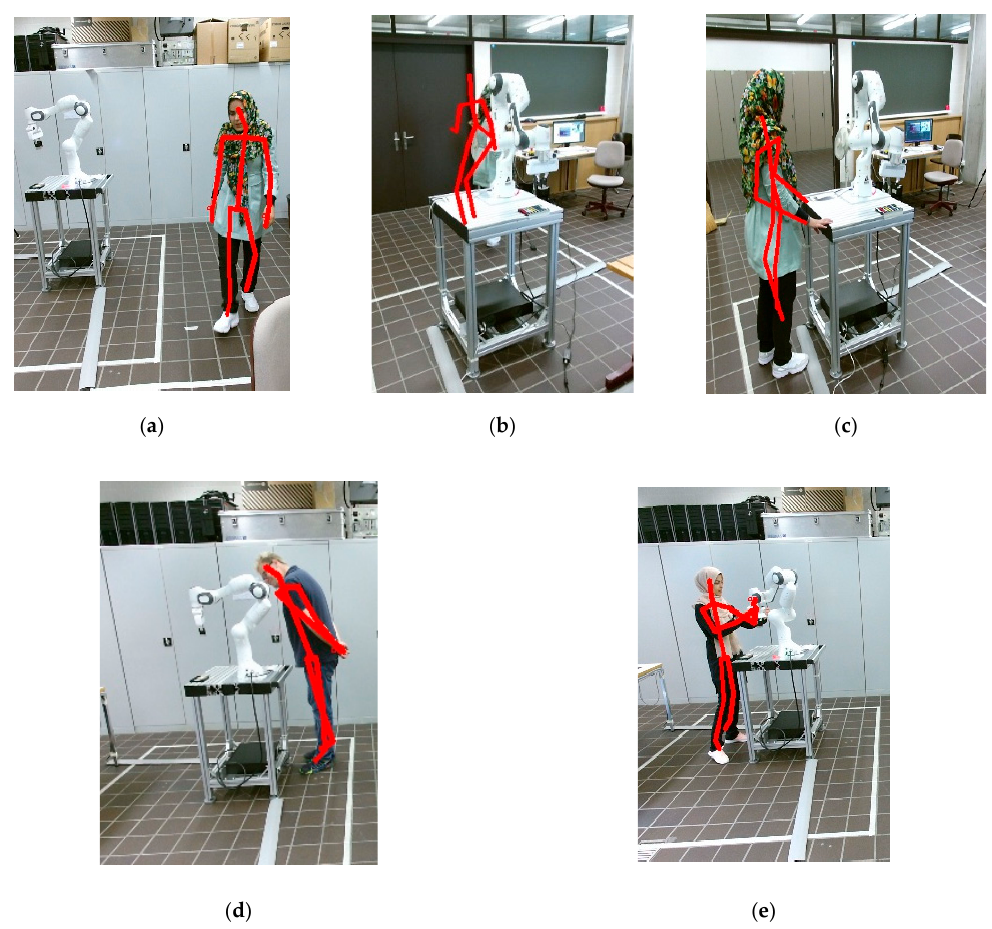
Figure 4. Type of human actions: ( a ) Passing: operator is just passing by, without paying attention to the robot. ( b ) Fail: blind spots or occlusion of the visual field may happen for a camera, in this situation the second camera takes over detection. ( c ) Observation: operator enters the working zone, without any interaction intention and stands next to the robot. ( d ) Dangerous Observation: operator proximity is too close, especially his head is at danger of collision with the robot. ( e ) Interaction: operator enters the working zone and prepares to work with the robot.